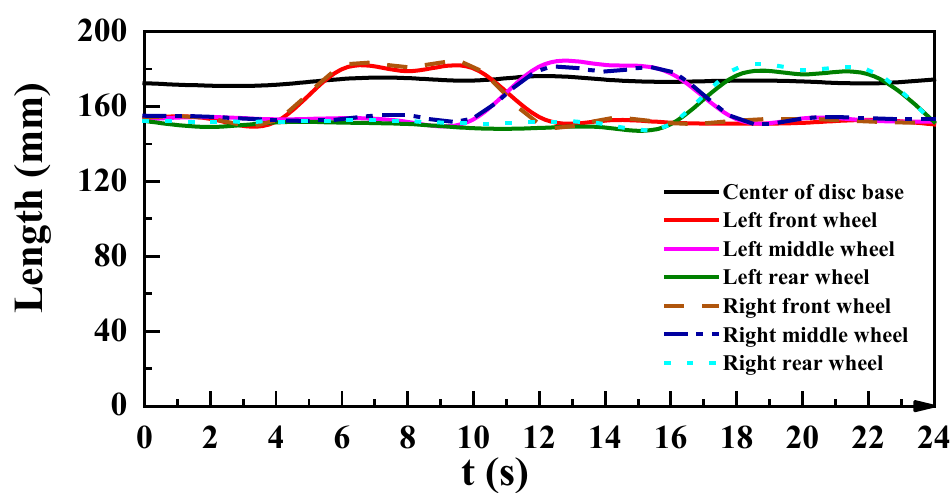
Figure 20. Movement track of plate and wheel center when crossing trench.